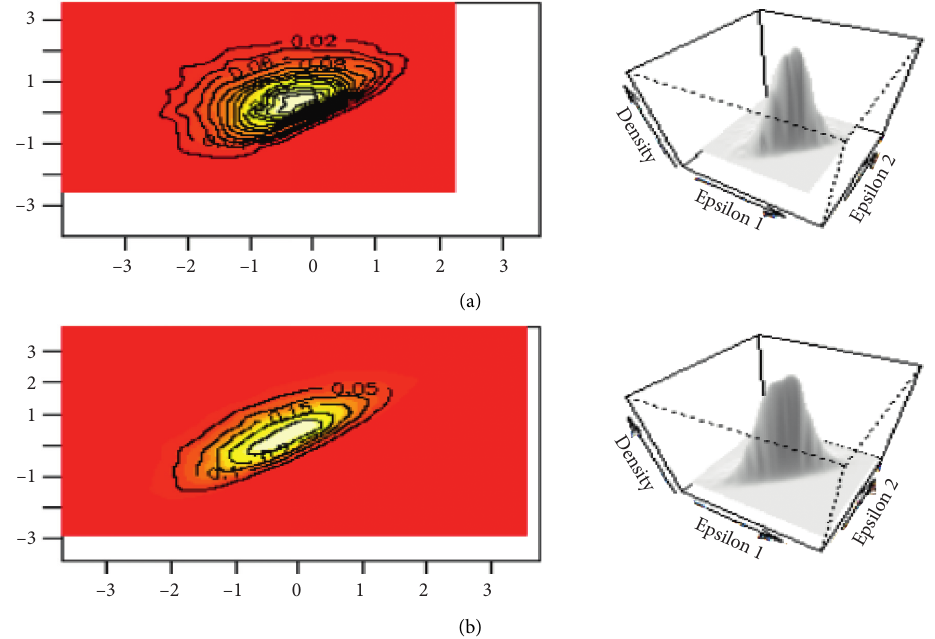
Figure 2: Simulation of (a) uncorrelated and (b) correlated bivariate normal skew errors for n �